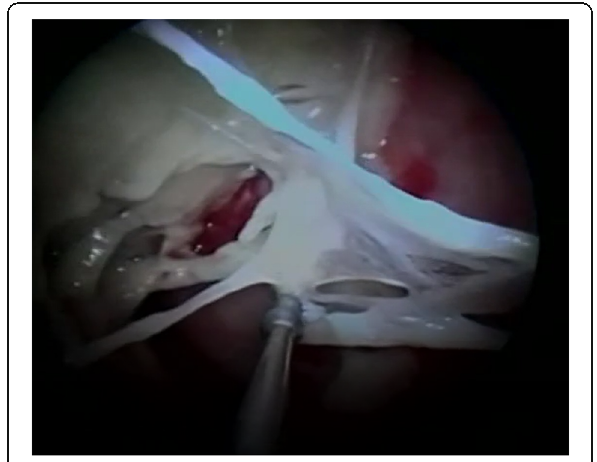
Fig. 1 Biopsy forceps used to cut intrapleural